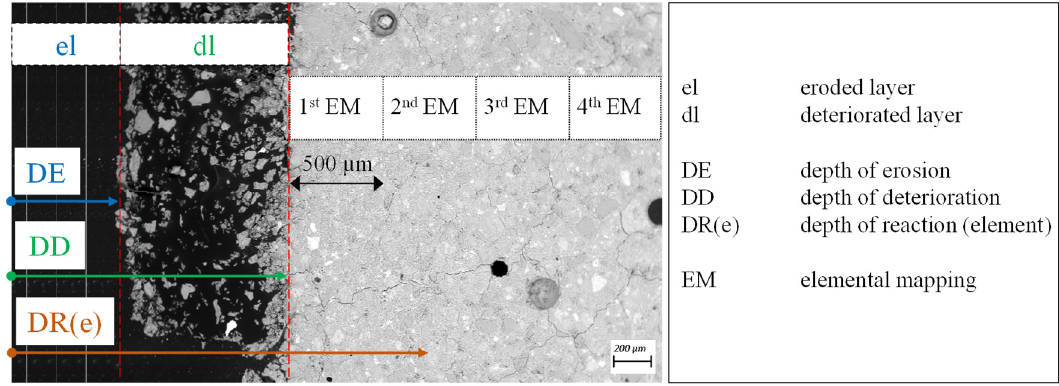
Figure 2. Description of a used terminology: eroded layer (el), deteriorated layer (dl), depth of erosion (DE), depth of deterioration (DD), and depth of reaction for specific elements (DR(e)). The positioning of SEM-EDX elemental mapping (EM) for profile evaluation of the sulfuric acid-induced degradation.